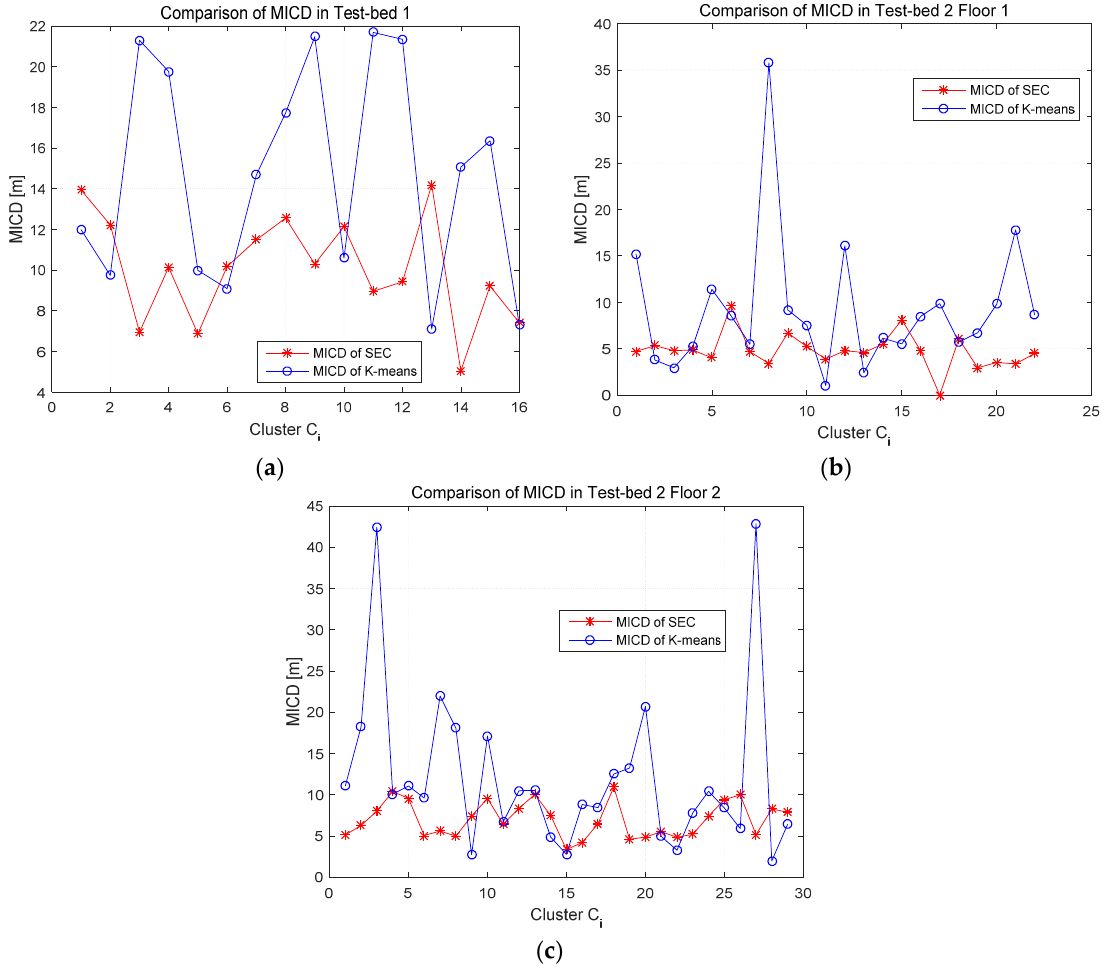
Figure 10. Comparison of Mean Intra-Cluster Distance (MICD) between K-means and SEC clustering: ( a ) MICD comparison in Test-bed 1; ( b ) MICD comparison in Test-bed 2 Floor 1; and ( c ) MICD comparison in Test-bed 2 Floor 2.